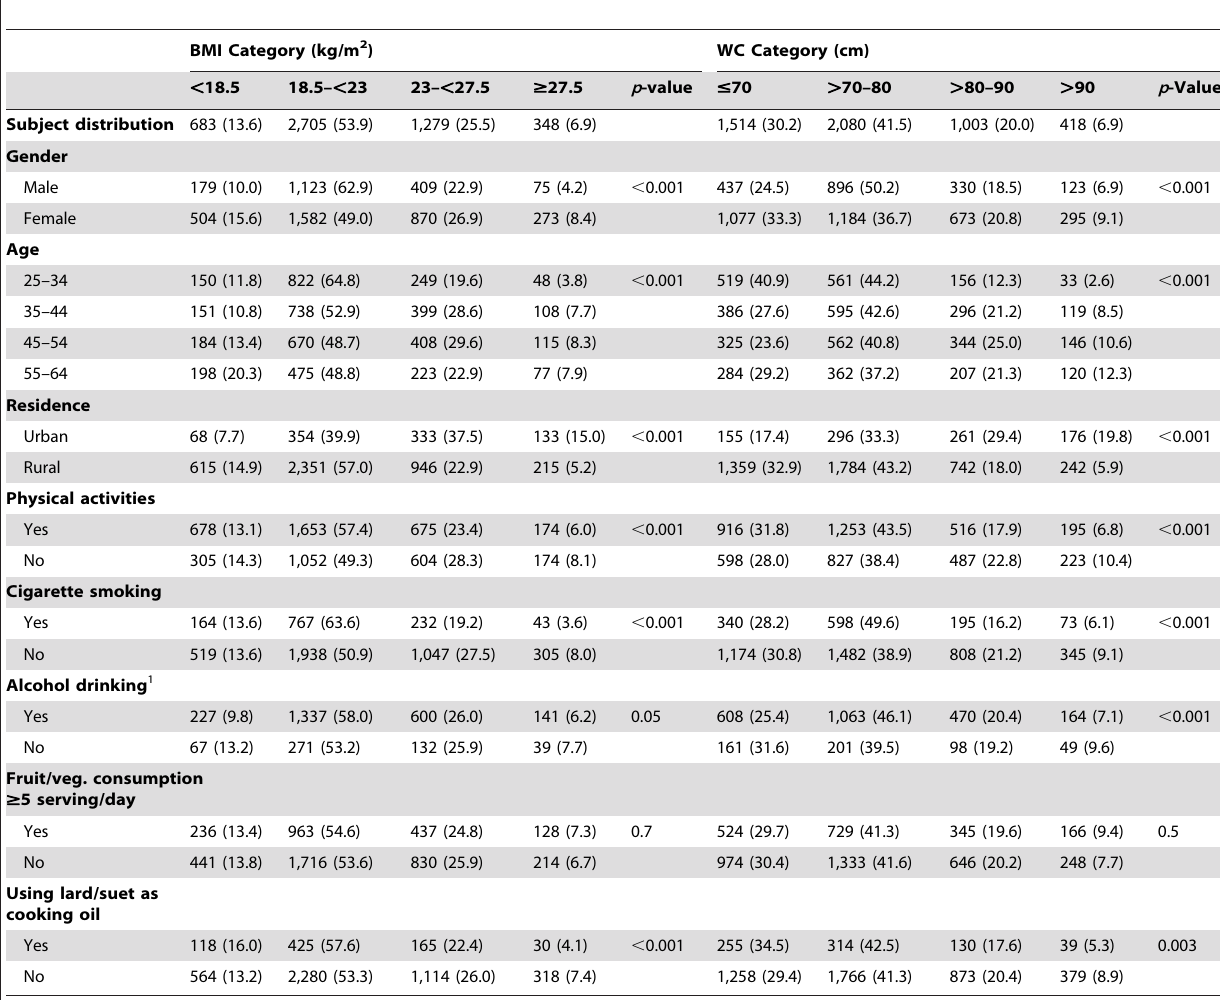
Table 2. Prevalence of risk factors of non-communicable diseases (NCDs) across different stratifications of body mass index (BMI) and waist circumference